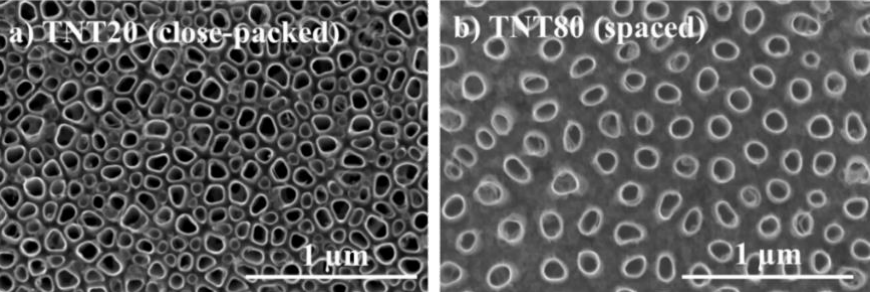
Figure 1. Top view SEM images showing the morphology of the nanotubes with two different intertube spacings: ( a ) TNT20, and ( b ) TNT80.